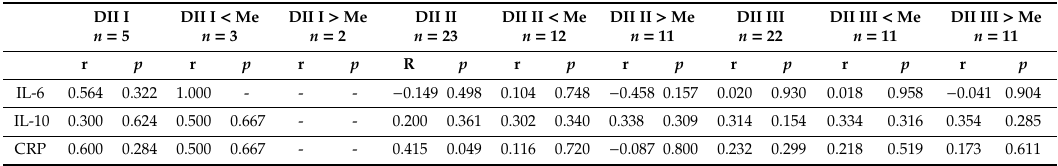
Table 6. Correlation analysis of DII score with IL-6, IL-10, and CRP levels in the particular trimesters among pregnant women with complicated